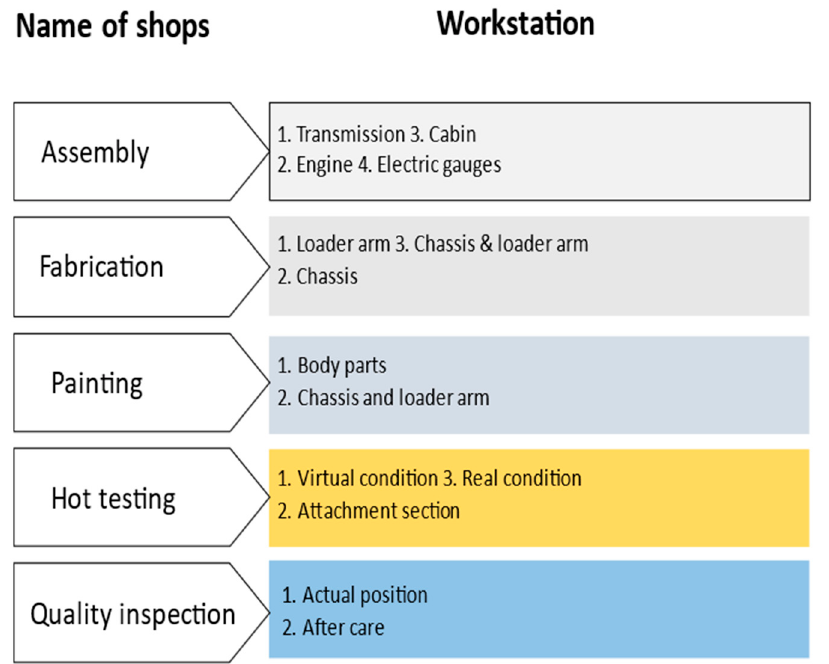
Figure 10. Modified production shop floor management.